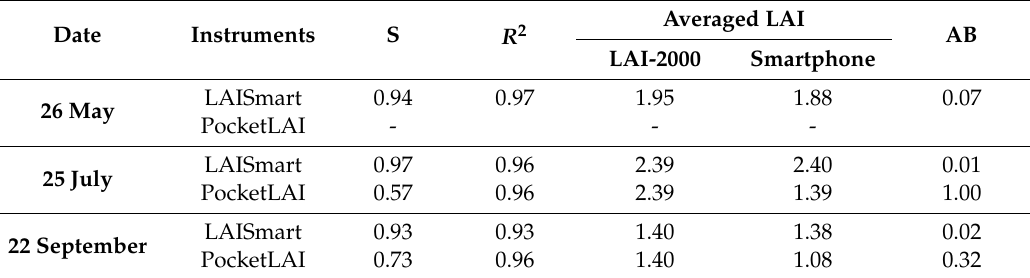
Table 3. Statistics parameters of the measured and reference LAI